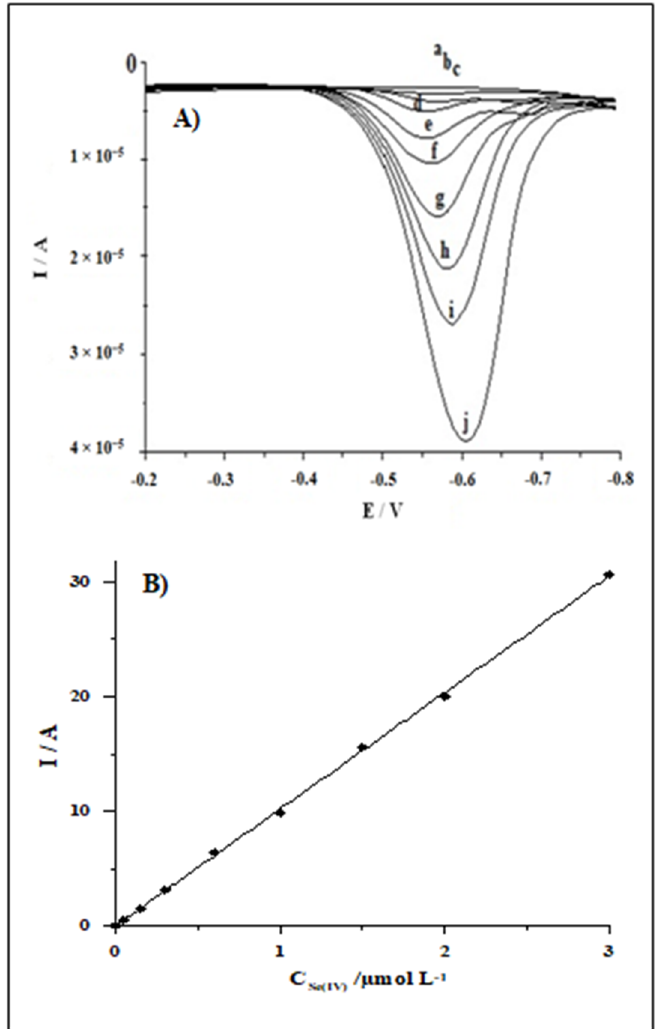
Figure 5. The voltammograms obtained at the BiFE in the supporting electrolyte containing increasing concentrations of Se(IV) ( A ). Concentration of Se(IV): 0 (a), 0.003 (b), 0.05 (c), 0.15 (d), 0.3 (e), 0.6 (f), 1 (g), 1.5 (h), 2 (i), 3 (j) µmol L − 1 . Supporting electrolyte: 0.1 mol L − 1 acetic acid, 1.9 × 10 − 5 mol L − 1 Bi(III). Inset the corresponding calibration plots ( B ). The analytical parameters of the proposed procedure and of other stripping voltammetric procedures using mercury free working electrodes for trace selenium ions determination are compared in Table 1. Table 1 . Comparison of parameters of the proposed procedure with other stripping voltammetric procedures using eco- friendly mercury free working electrode for trace Se(IV) determination. The procedures are arranged according to the growing detection limit.